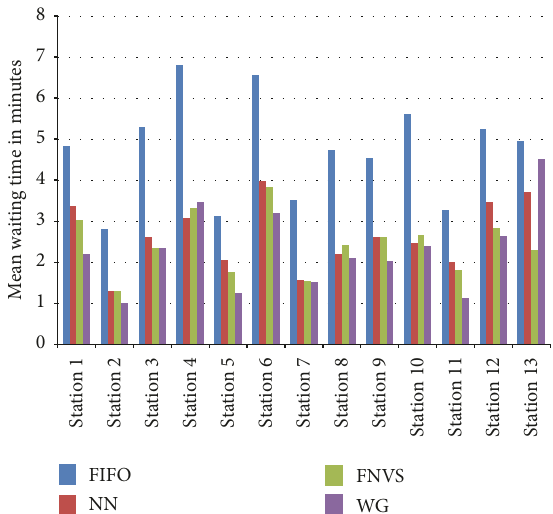
Figure 13: Wait time for each station with 100 vehicles.